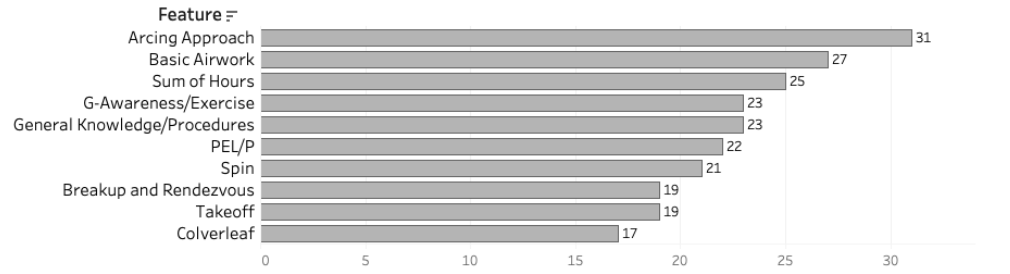
Figure 17. Top 10 features to identify successful strike students.